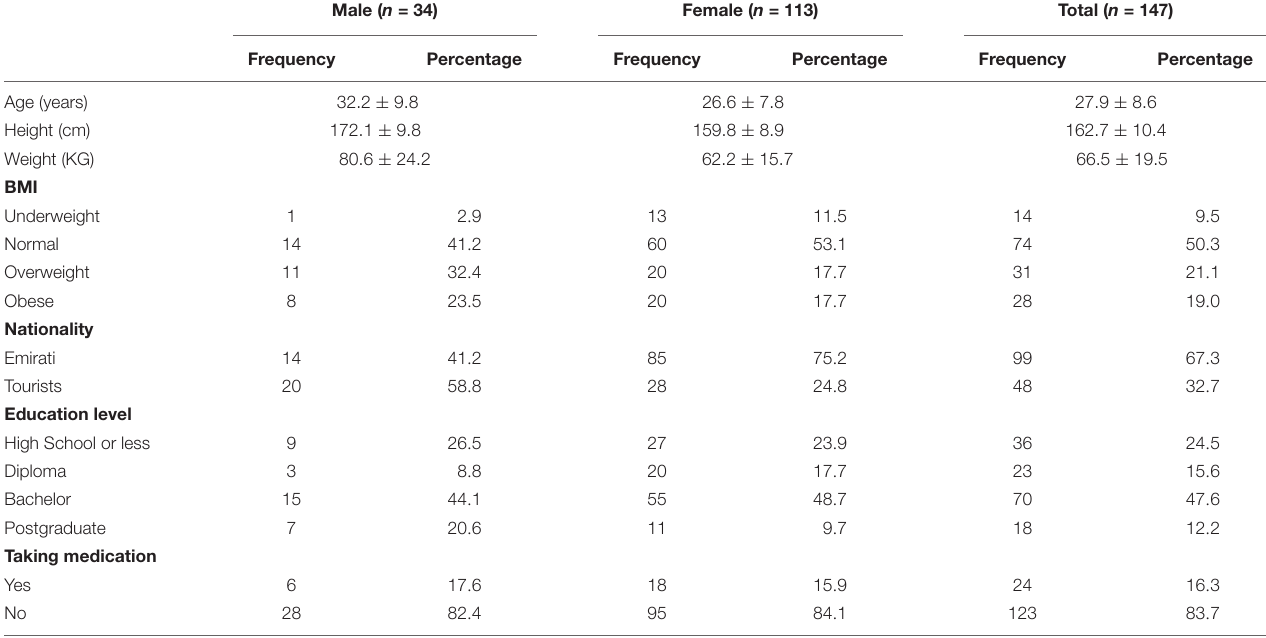
TABLE 1 | Characteristics of study participants according to gender ( n = 147).